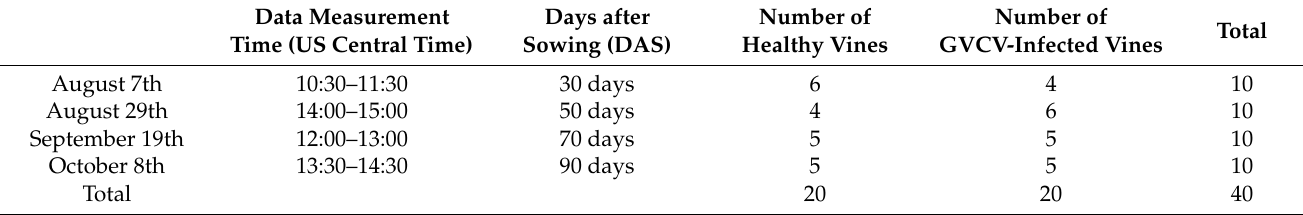
Table 1. Summary of sample size by grapevine health status and measurement dates. GVCV, grapevine vein-clearing virus. Data